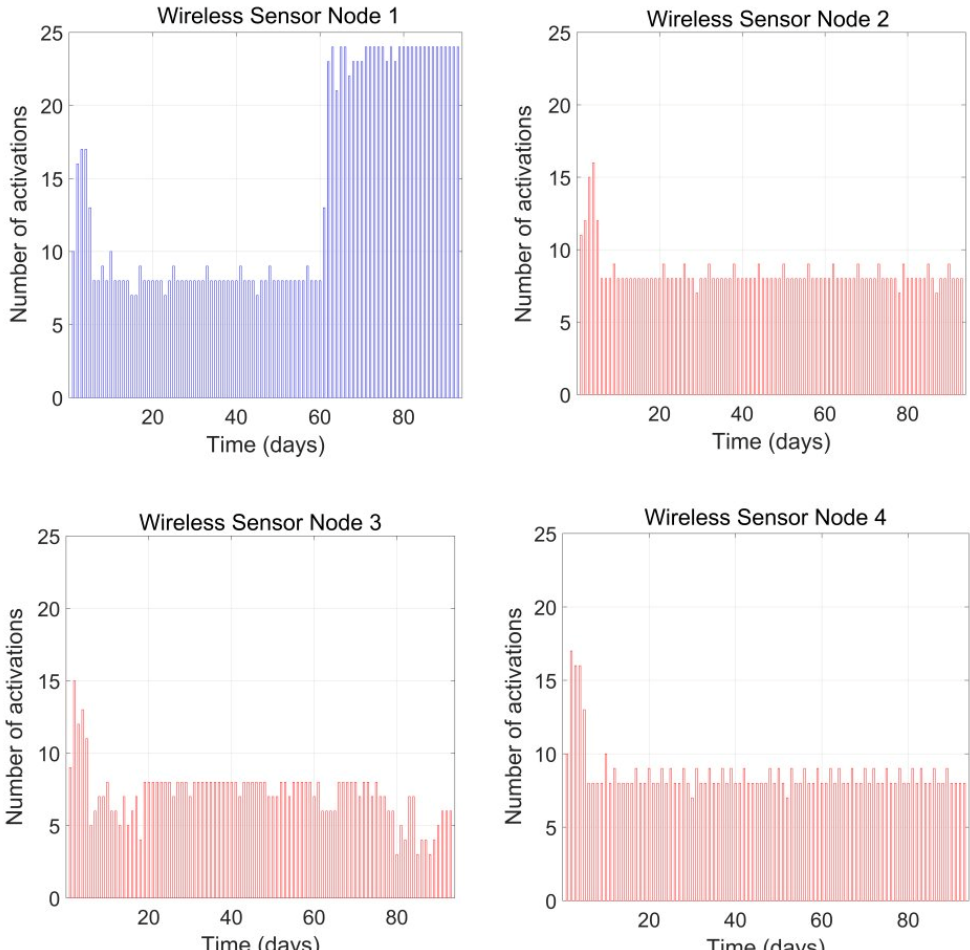
Figure 5. Number of activations per day of the sensor nodes during the experimental period.